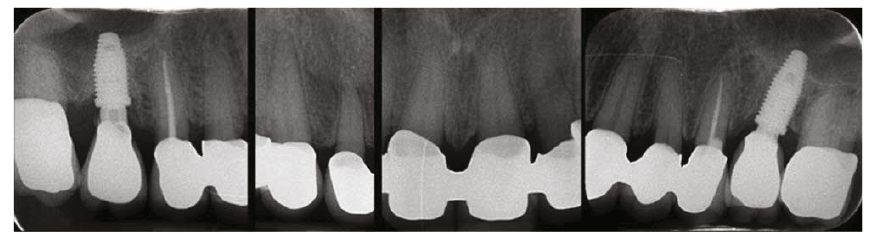
Figure 20: Periapical radiograph taken 24 months after the